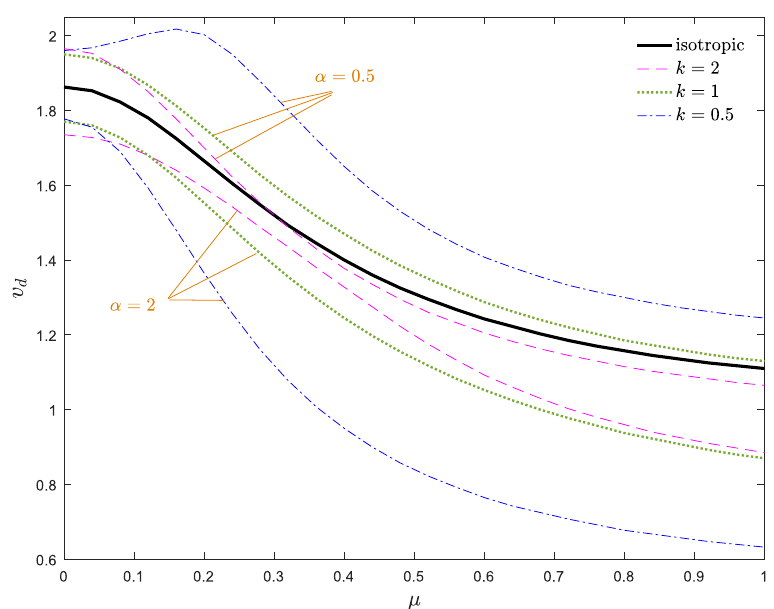
Figure 14. Critical divergence velocity of the system against nonlocal parameter for ζ = 0, k f = 0.5.